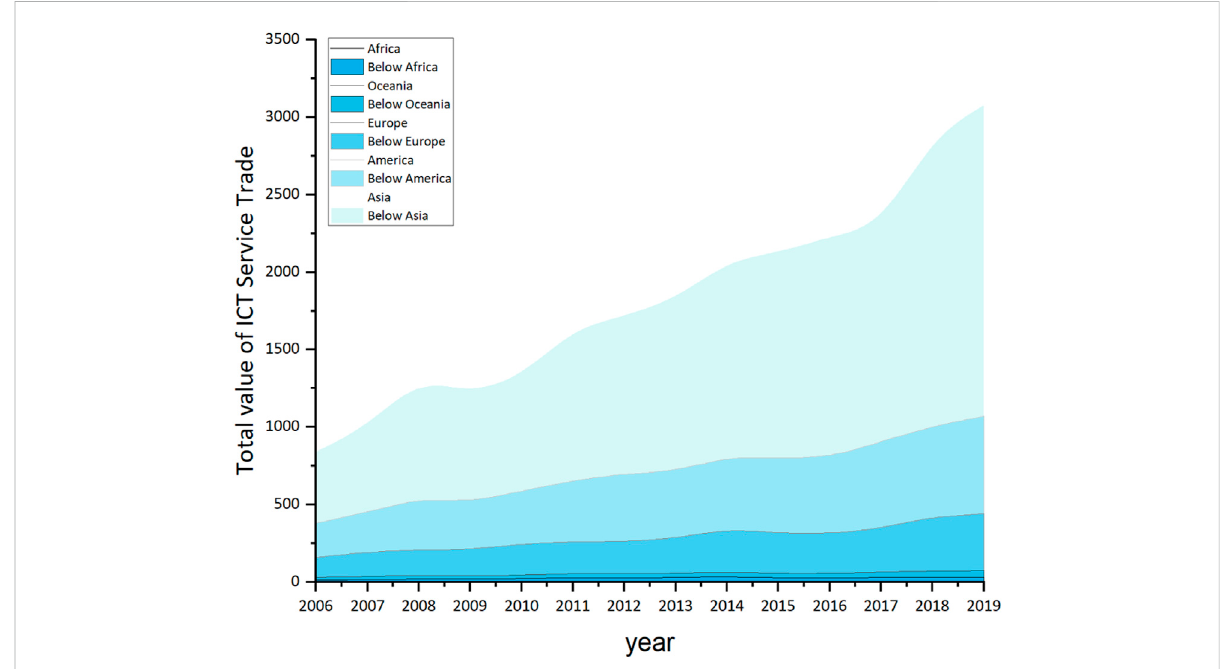
FIGURE 1 2006 – 2019 trade volume on ICT services in different regions of the world. Note: source from the United Nations Conference on Trade and Development Statistics (UNCTAD stat). Unit: billion